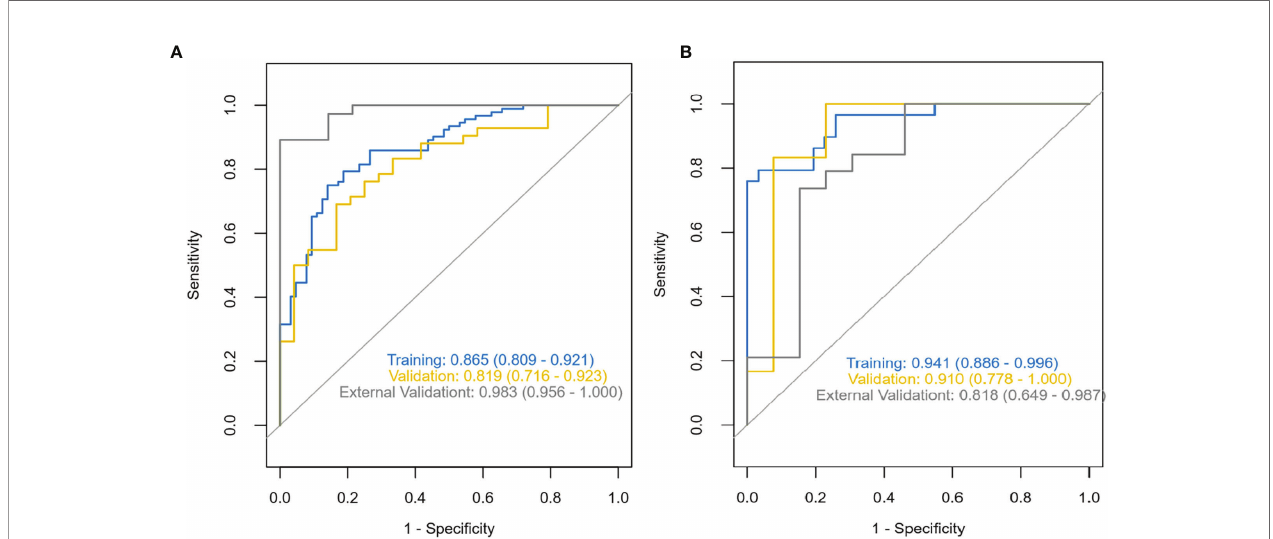
FIGURE 5 | ROC characteristic curves and corresponding AUC values for the pretreatment MRI radiomics model (A) and the Delta radiomics model (B) . ROC, receiver operating characteristic; AUC, area under the receiver operating characteristic curve. TABLE 1 | The diagnostic effects of the pretreatment MRI radiomics model and Delta radiomics model in predicting the ef fi cacy of IC-CCRT for NPC. ROC Accuracy Sensitivity Speci fi city NPV PPV MRI radiomics Training set 0.865 0.827 0.837 0.812 0.776 0.865 Validation set 0.819 0.788 0.833 0.708 0.708 0.784 Training set 0.941 0.883 0.910 0.880 0.818 0.781